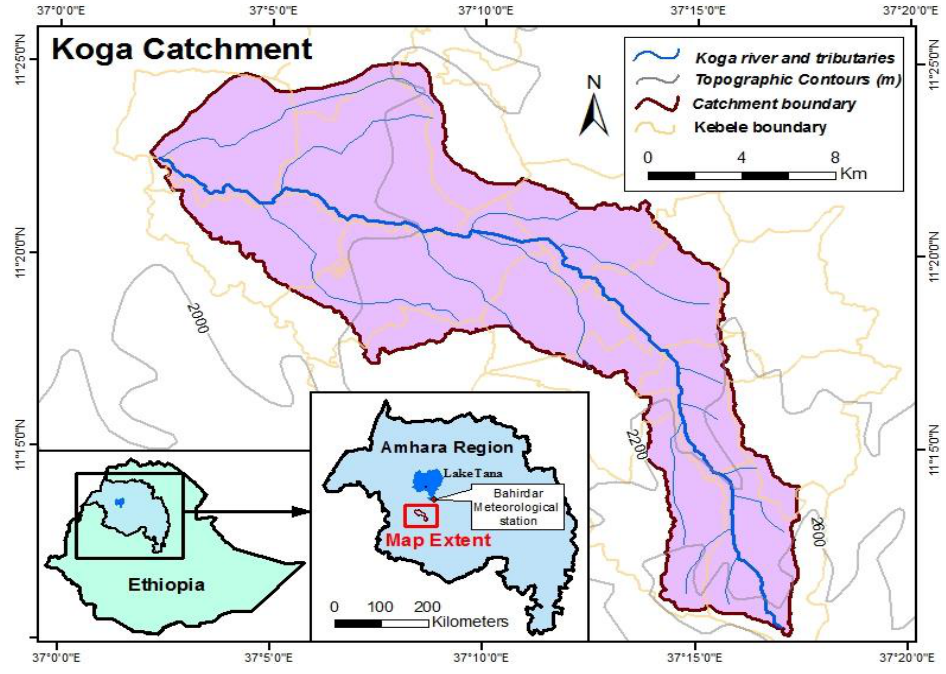
Figure 2. Location Map of the Koga Catchment